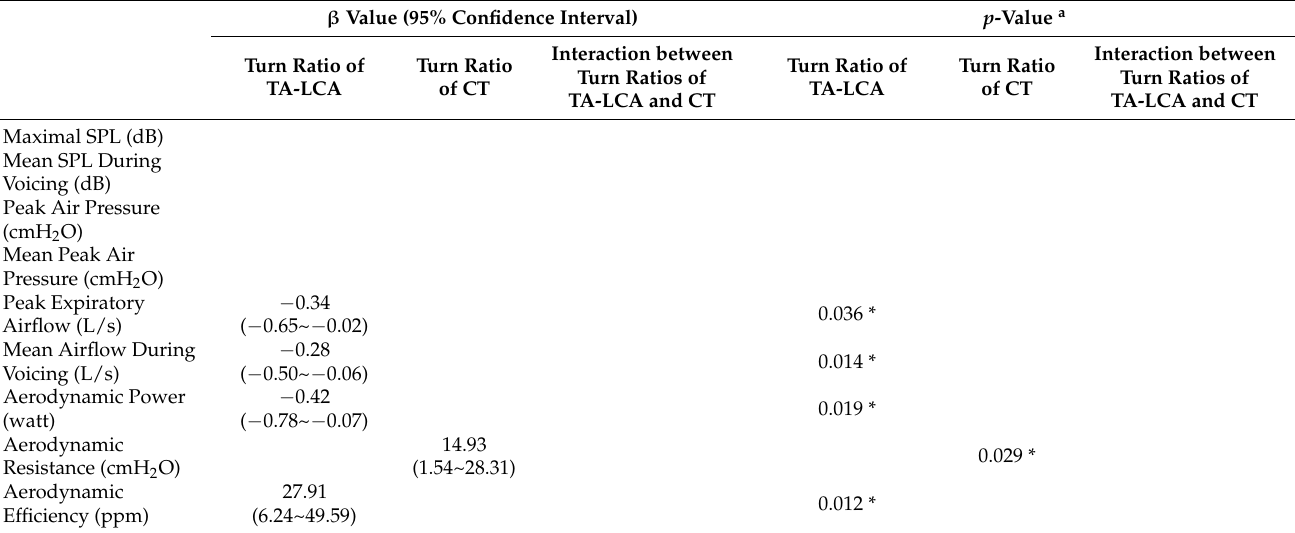
Table 5. Stepwise regression between LEMG and